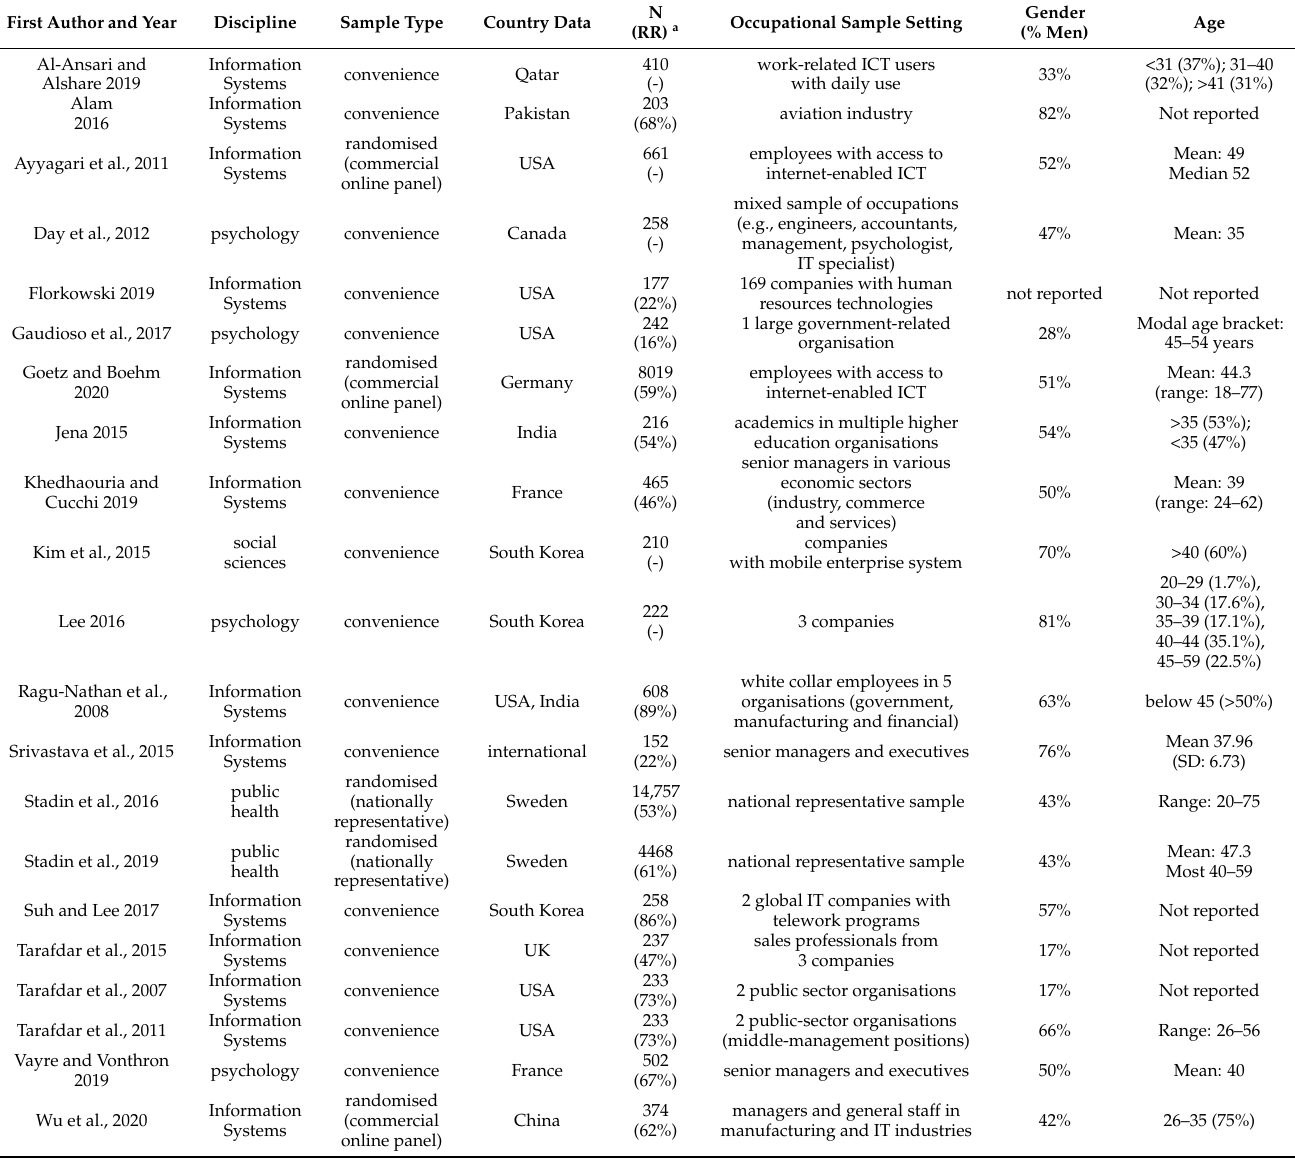
Table 2. Occupational setting and